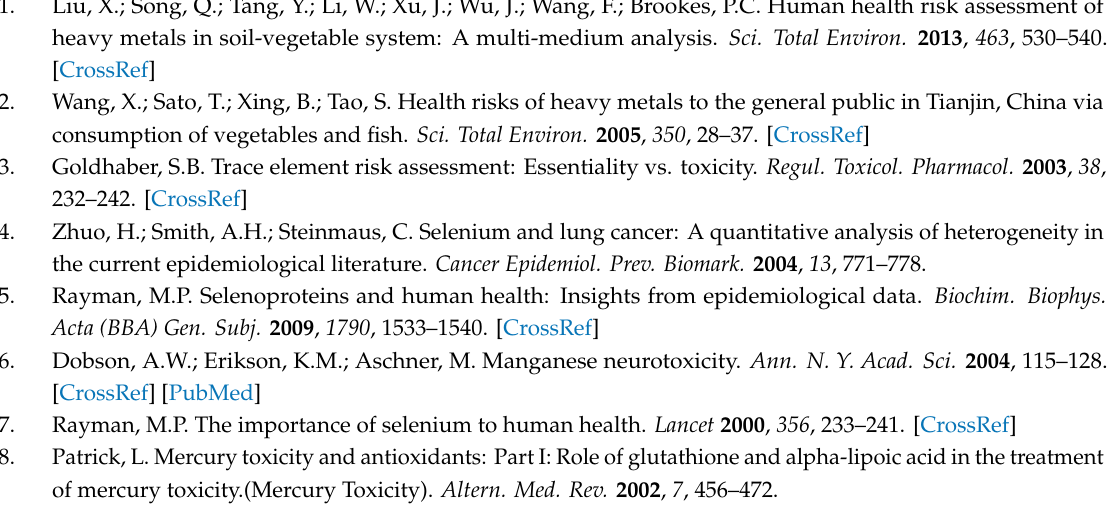
Table S1: Basic information for participants (N = 37); Table S2: Analytical instruments; Table S3: Analytical results (mg / kg) of certified reference materials; Table S4: Limit of detection (LOD) of metals for each sample